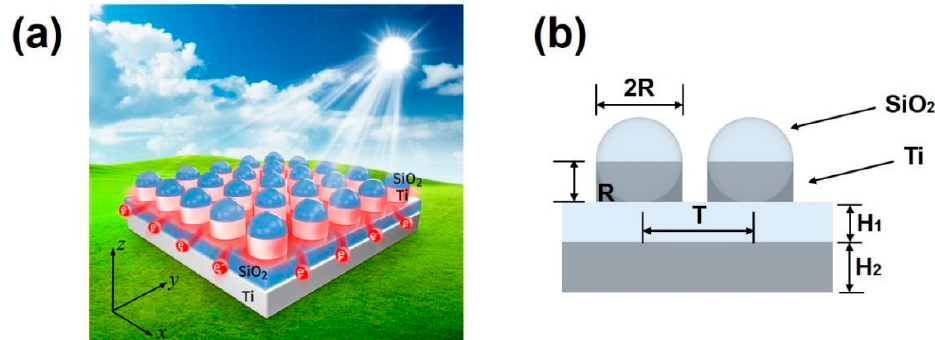
Figure 1. ( a ) Schematic diagram showing the ultra-broadband solar energy absorber. ( b ) The front view of the absorber.